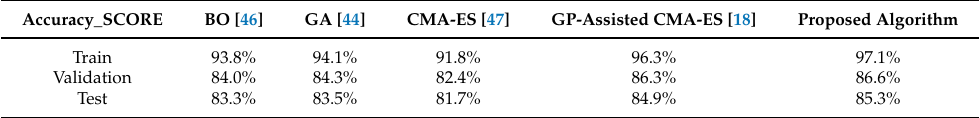
Table 5. Simulated results of all experimental algorithms with 1000 spiking neurons on KTH.